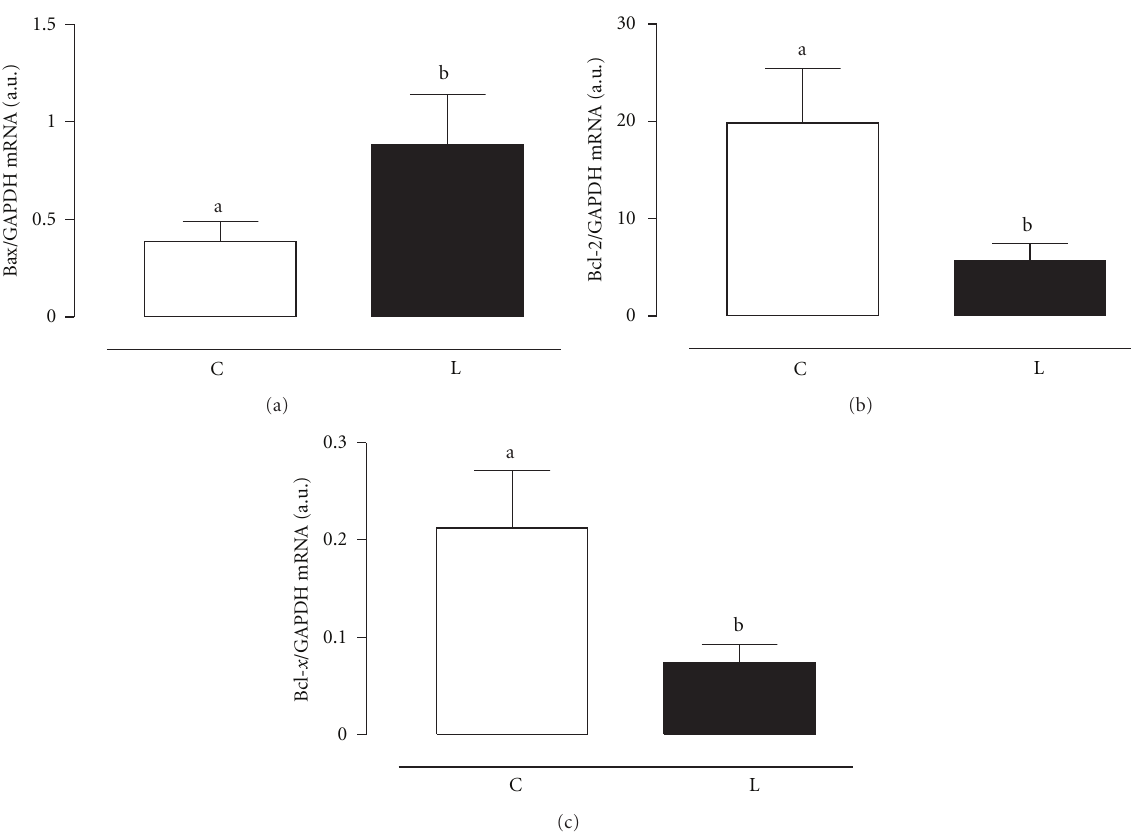
Figure 1: Gene expression of Bax (a), Bcl-2 (b), and Bcl-x (c) in the human hyperplasic prostate tissue after leptin treatment, 50 ng/mL, (Leptin) or not (Control) for 3 hours. GAPDH was used as an internal control. Primer sequences are listed in the Table 1. Data are represented as mean ± SEM of 15 individuals. Di ff erent letters mean statistically